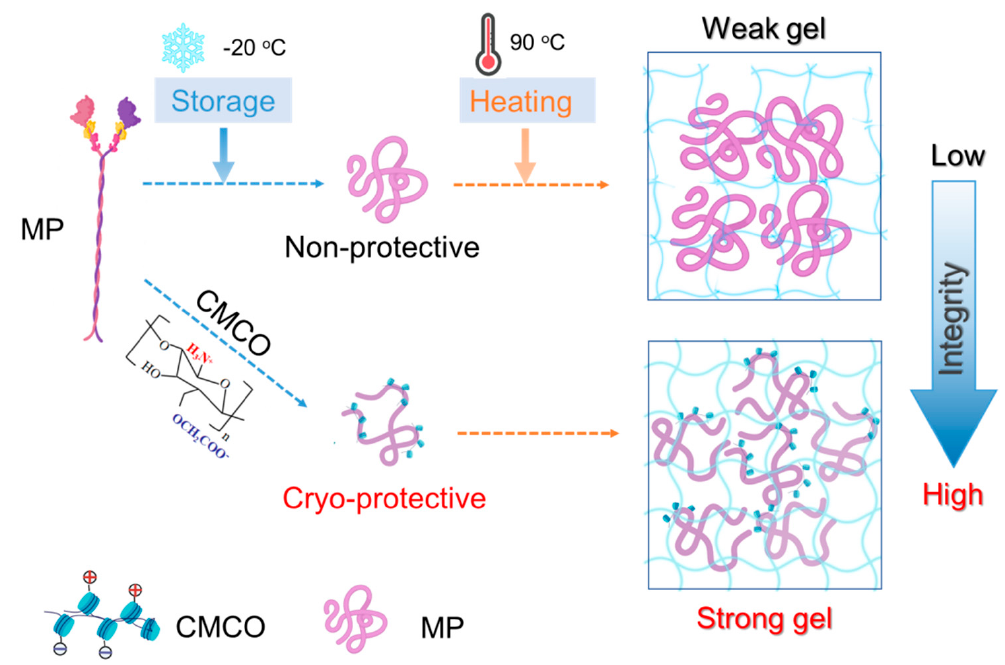
Figure 7. Schematic representation of the cryoprotective mechanism of CMCO for MP in frozen surimi.